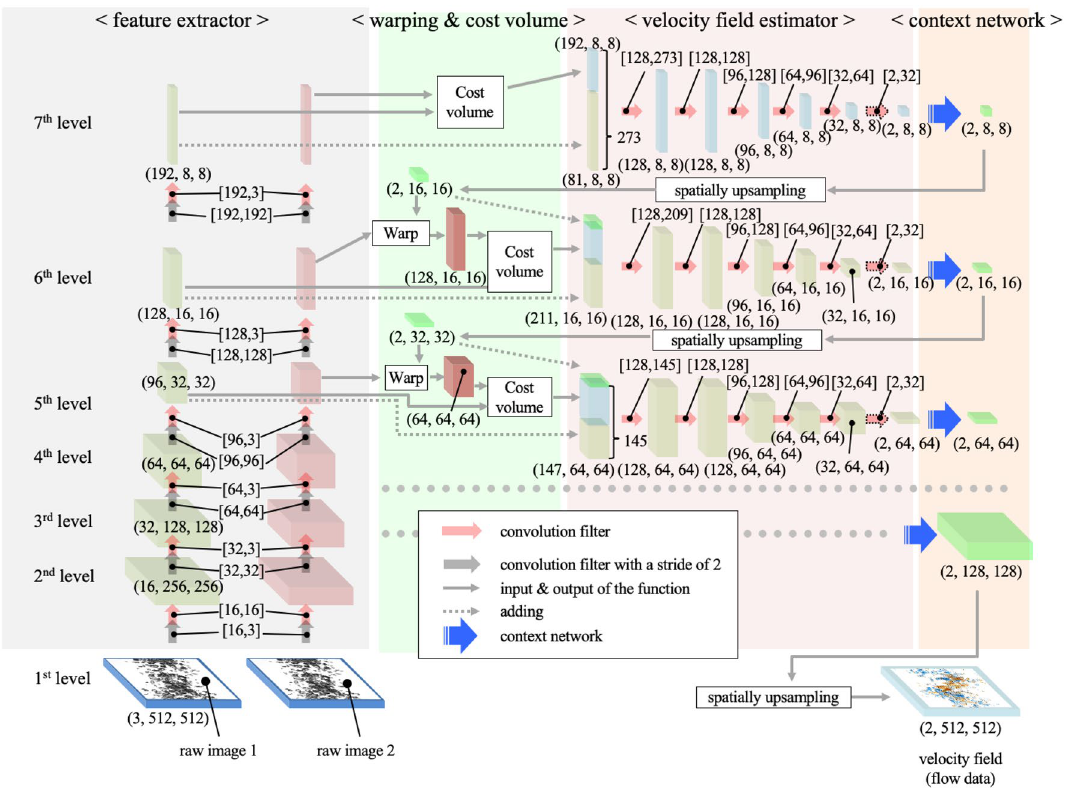
Figure 12. Architecture of the PWC-Net proposed by Sun et al. 35